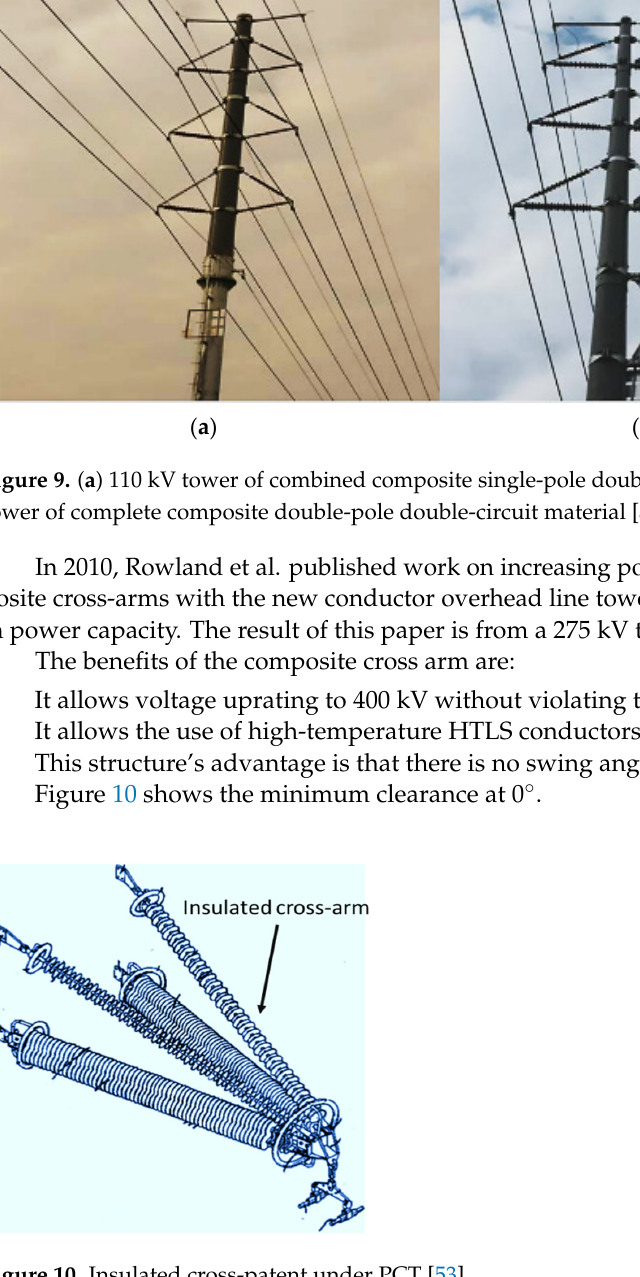
Figure 8. Fibre cross ‐ arms on steel tower [49].